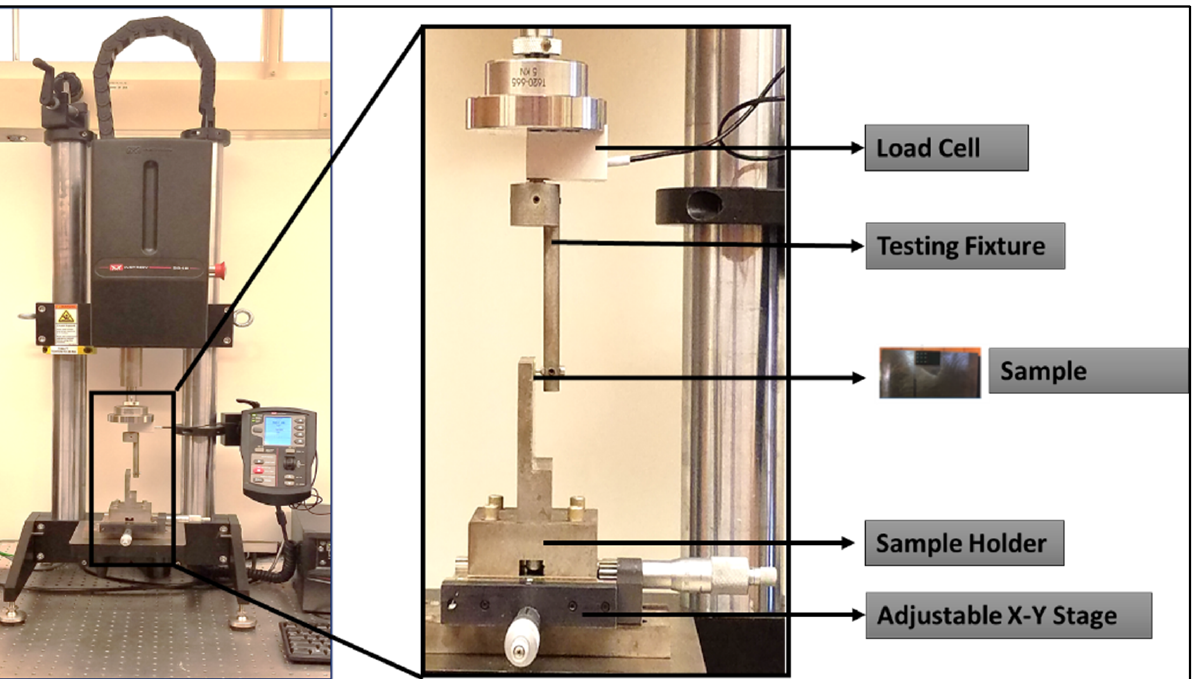
Figure 2. Instron 5948 testing machine.